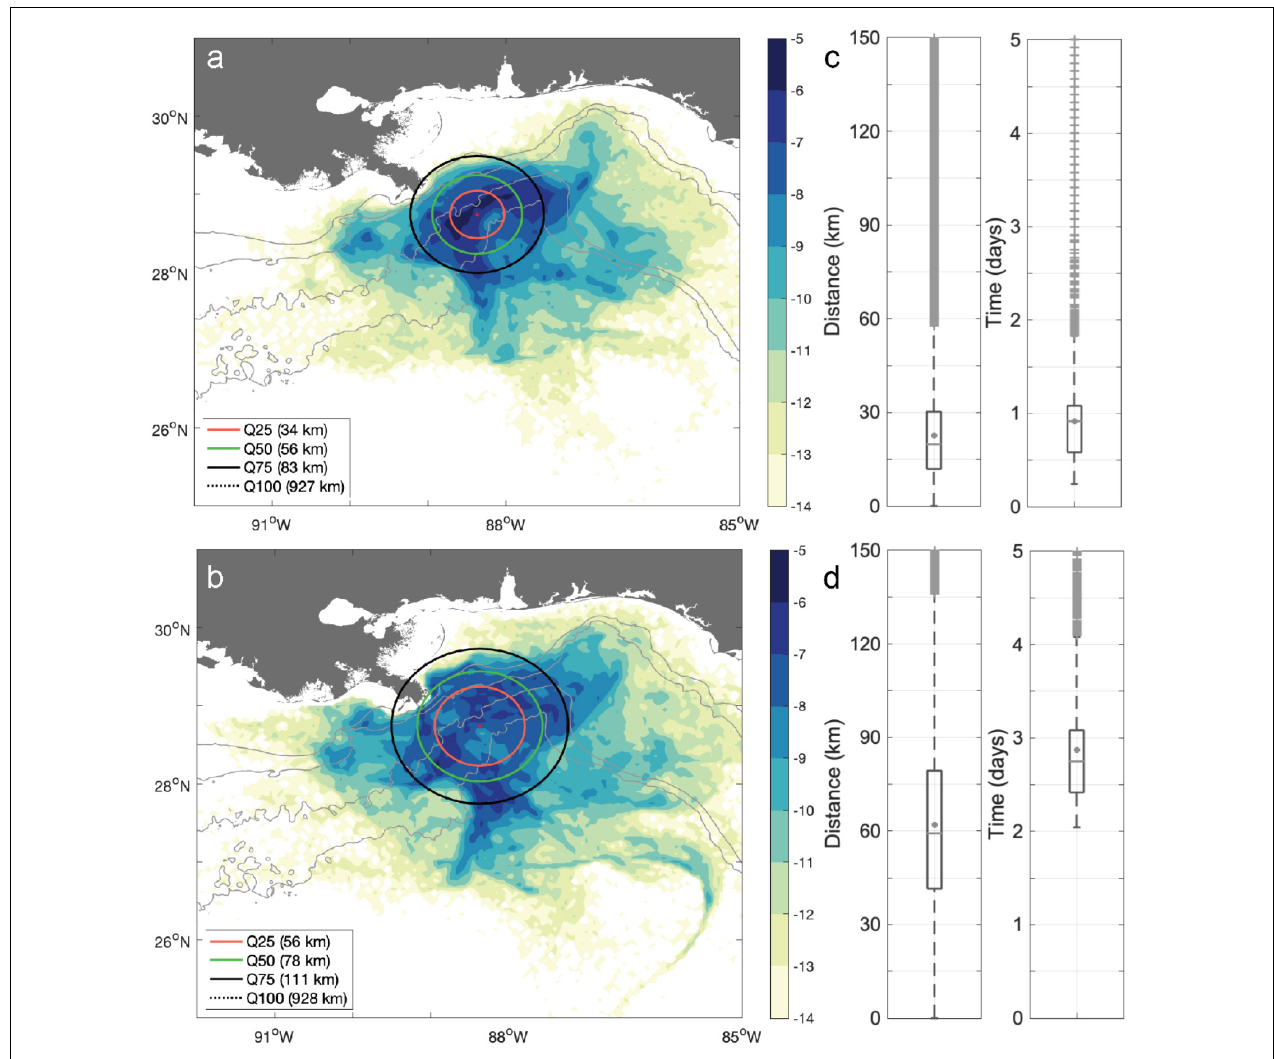
FIGURE 3 | Probability (PDF) of photooxidized components (POCs) formation during the DWH blowout (a,b) . Solid lines represent areas containing percentiles of POCs formation (Q25: quantile 0.25, Q50: quantile 0.5, Q75: quantile 0.75 and Q100: quantile 1), which radii are computed from the vertical axis of the Macondo well. Onset of the photooxidation process occurs as soon as the oil droplet reaches the surface, but here the likelihood of photooxidative changes is based on the observed thresholds of cumulative solar irradiance after Ward et al. (2018a). Upper panel are for the photooxidized compounds considering a lower solar irradiance threshold (1.16*10 7 J m − 2 ), and lower panels considering a higher solar irradiance threshold (6.60*10 7 J m − 2 , Ward et al., 2018a). Boxplots (right panels, c,d ) provide the distribution of the distance and time traveled to the likelihood of photooxidation, once the droplet reached the surface (0–1 m depth).